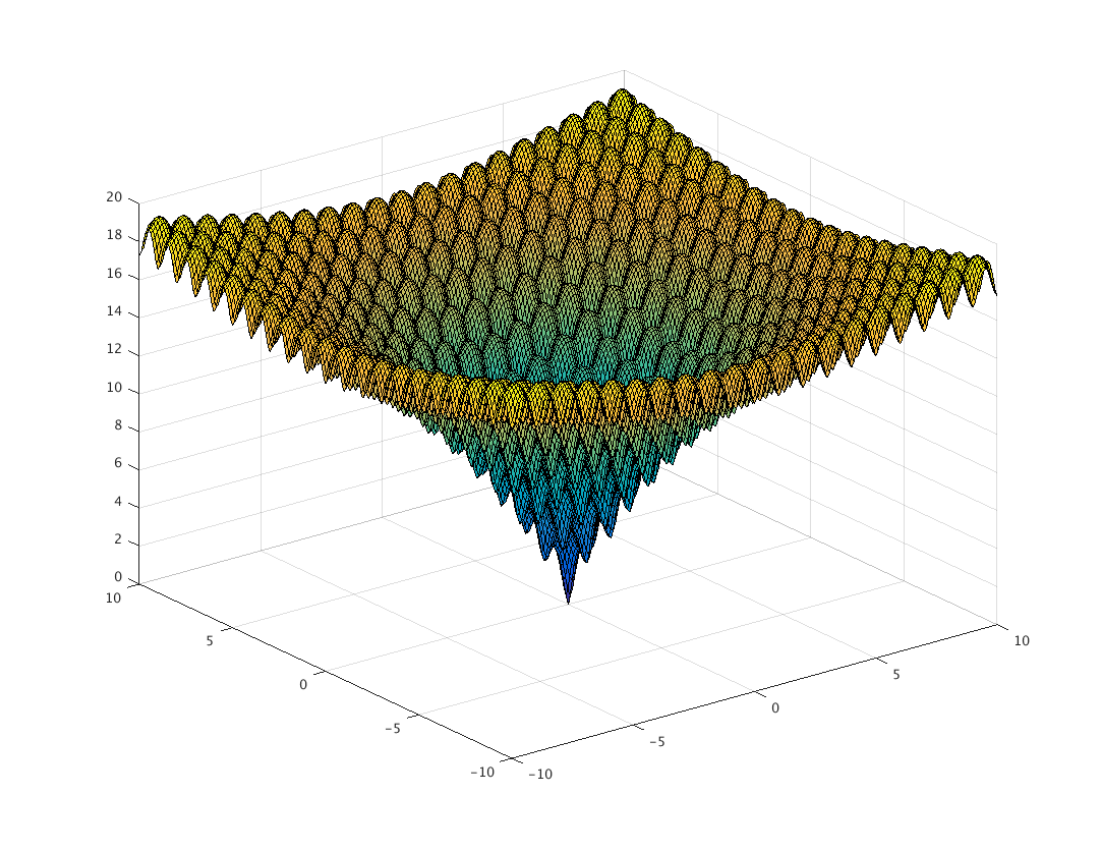
Figure 8. Three-dimensional graph of the Ackley function.